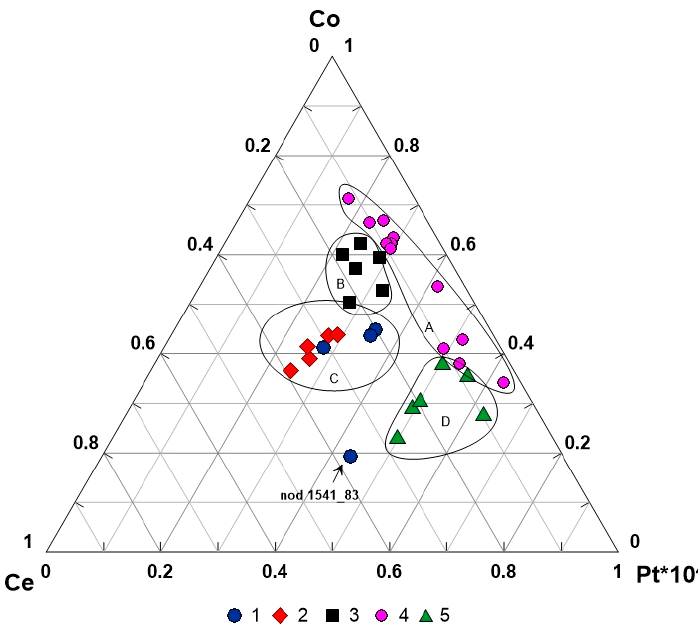
Figure 8. Ternary diagram showing nodule composition in Co–Ce–Pt × 10 4 coordinates: A—field of diagenetic nodules from the Pacific Ocean, B—field of hydrogenous nodules from the Pacific Ocean, C—field of hydrogeneous nodules from the Atlantic Ocean, D—field of marginal sea nodules. 1—nodules from the Brazil Basin (except nod 1541_83); 2—hydrogenous nodules from the Cape Basin; 3—hydrogenous nodules from the Pacific Ocean [14,15], reference samples GSPN-2, OOPE-601, OOPE-603; 4—diagenetic nodules [14,15], reference samples JMn-1, NOD-P-1, GSPN-3, OOPE-602; 5—marginal sea nodules [15,17].